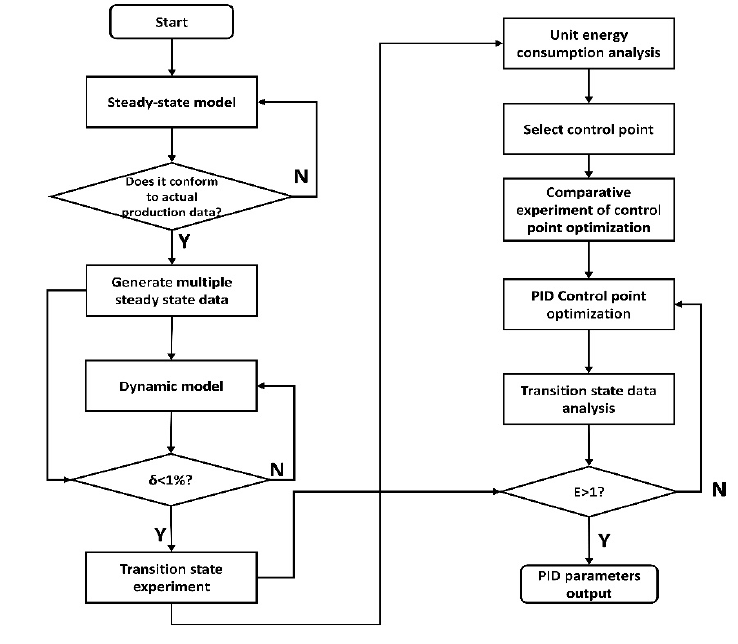
Figure 7. PID parameter optimization method framework based on energy consumption optimization under variable conditions. Y—yes and N—no.